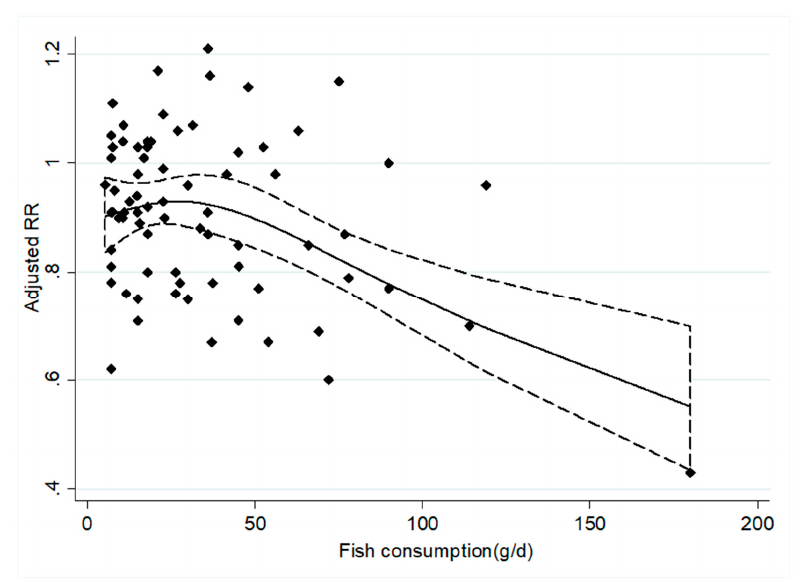
Figure 4. The dose–response analysis between the fish consumption and the CHD incidence. The diamonds represented the adjusted RRs for each exposure quantile of fish consumption in the included individual studies. The solid line and the long dash line represent the estimated relative risk (RR) and its 95% confidence interval (CI). Abbreviations: g/d, grams per day. Nutrients 2019 , 11 , x FOR PEER REVIEW